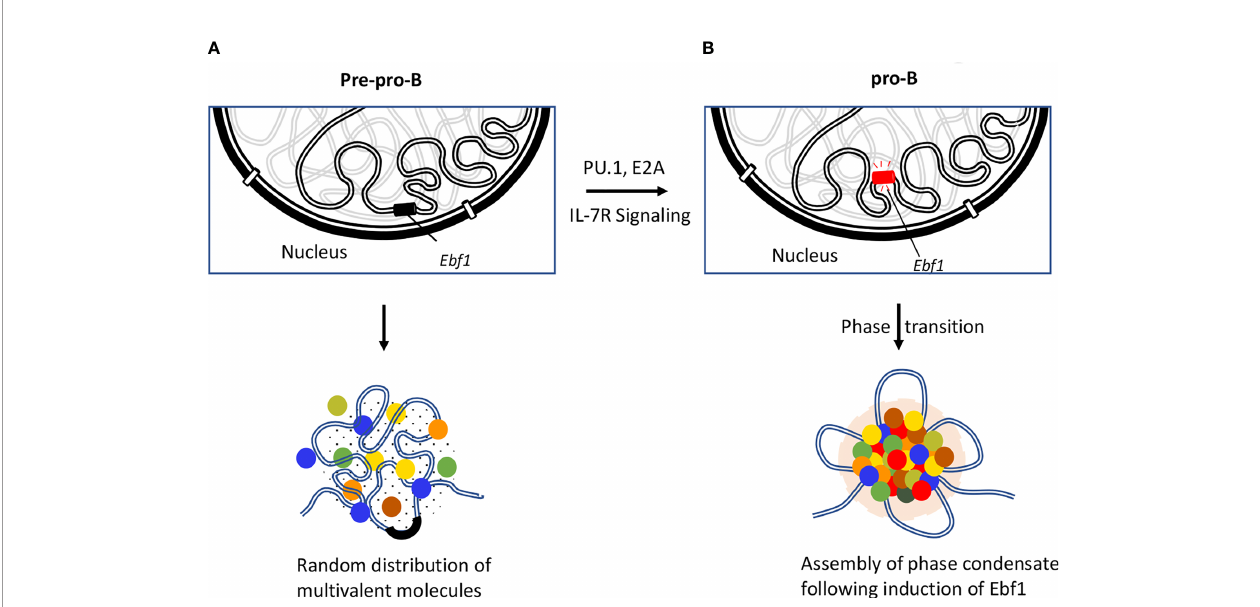
FIGURE 4 | Role of EBF1 in orchestrating phase separated condensates. Repositioning of Ebf1 locus is illustrated during the developmental transition from pre-pro- B to pro-B stage. (A) Genomic locus of Ebf1 is localized in close spatial proximity to the repressive compartment of the nuclear periphery at the pre-pro-B cell stage. In the absence of Ebf1, B lineage genes are transcriptionally silent due to inaccessibility of the TF to their target sites or lack of TF that are necessary for their activation. (B) The Ebf1 locus repositions from the transcriptionally repressive compartment to the nuclear interior. The Ebf1 locus becomes transcriptionally active in response to PU.1 and E2A binding as well as IL-7R mediated signaling. It has recently been proposed that following activation of Ebf1 at pro-B cell stage and beyond, Ebf1 coordinates the establishment of multivalent interactions involving transcription factors, co-activators and transcription initiation proteins containing unstructured fl exible regions to form a phase separation body